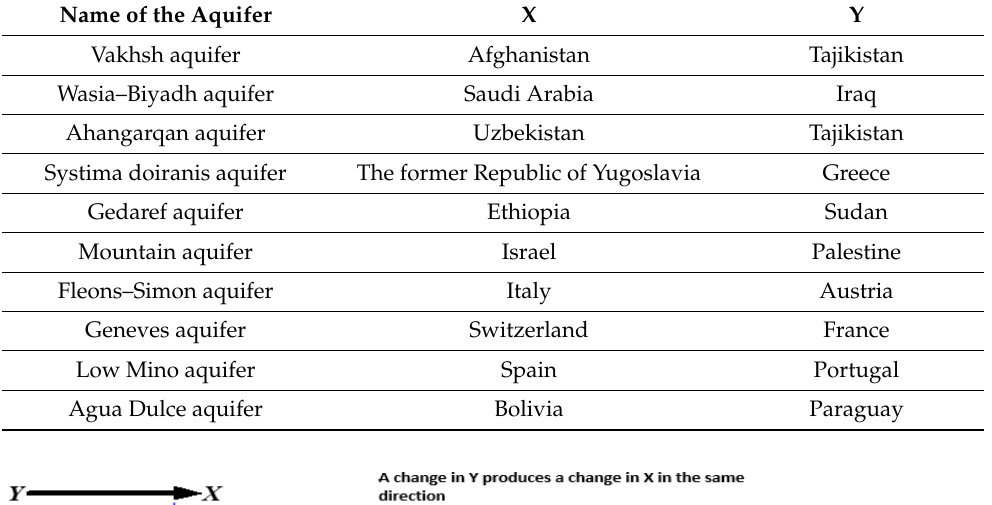
Table A5. Objective cases that can environmentally embrace HSA5.